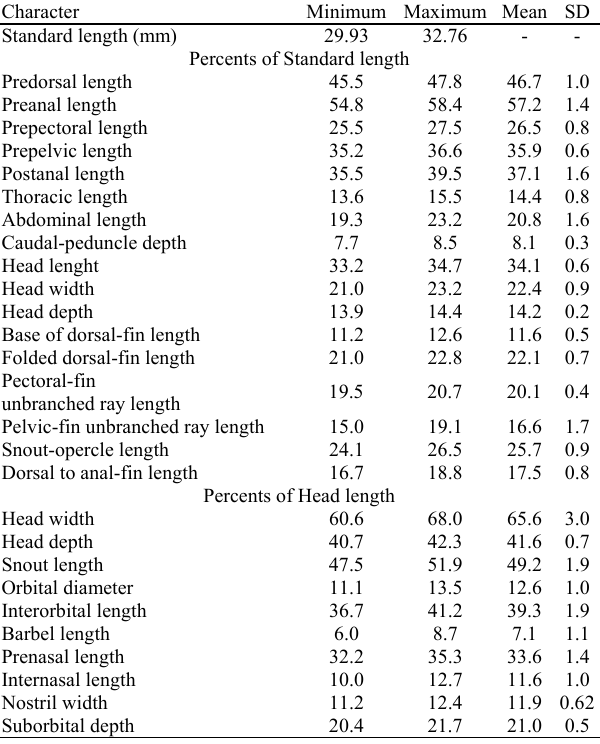
Table 3. Morphometric data for Microlepidogaster perforatus (MNRJ 31886, MZUSP 10216, 10217; n = 5). SD = Standard deviation.